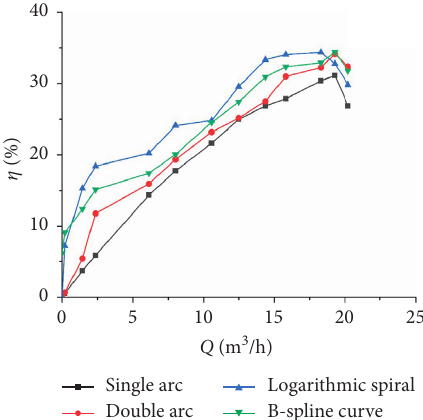
Figure 14: Q - η curves four